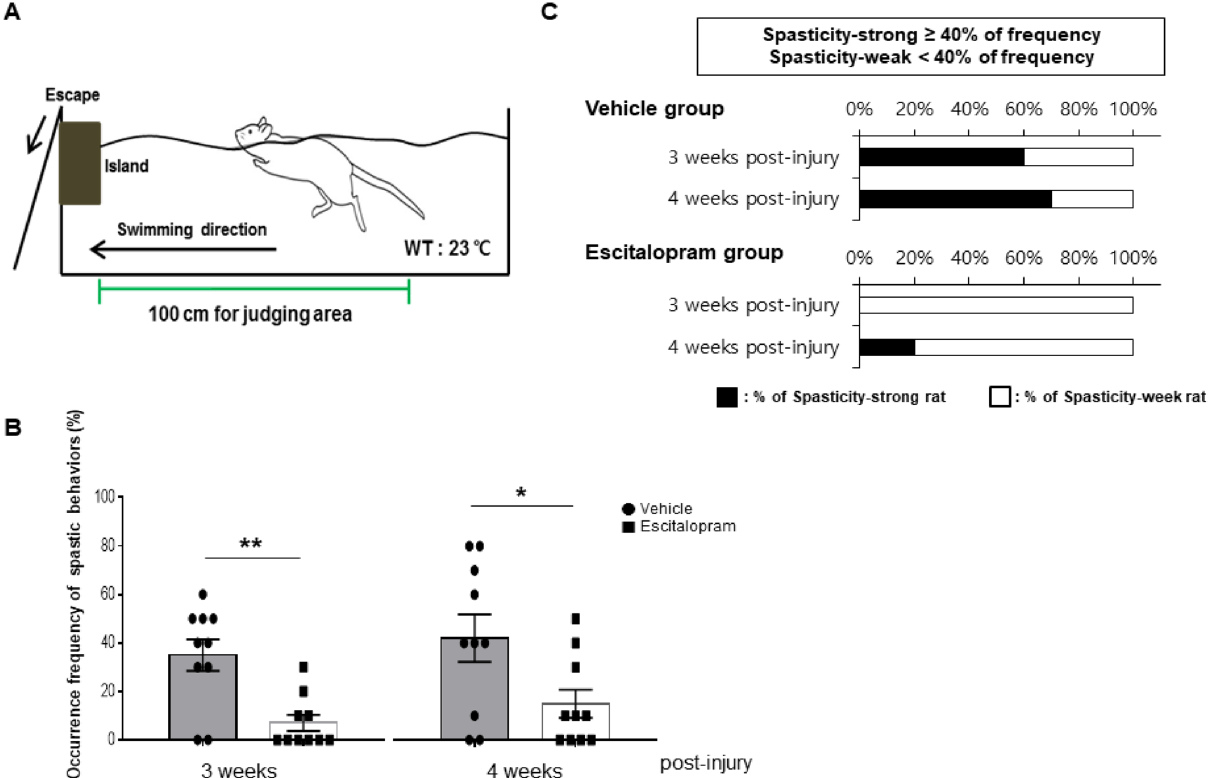
Figure 2. Effects of escitalopram on spastic behaviors during the swimming test and the ratio of spasticity- strong rats. ( A ) The configuration of the swimming test used in this study is presented. Spasm and clonus phases during the swimming test were counted in 10 swimming runs. WT water temperature. ( B ) The bar graph shows the mean occurrence frequency of spastic behavior (sum of spasm and clonus) during the swimming tests performed at 3 and 4 weeks after SCI (gray bar with round plots: vehicle-treated group, white bar with rectangular plots: escitalopram-treated group). * P < 0.05, ** P < 0.01. ( C ) The ratios of spasticity-strong rats at 3 and 4 weeks after SCI. Injured rats were classified as “spasticity-strong” if they showed over 40% frequency of spasticity-positive swimming runs during the swimming